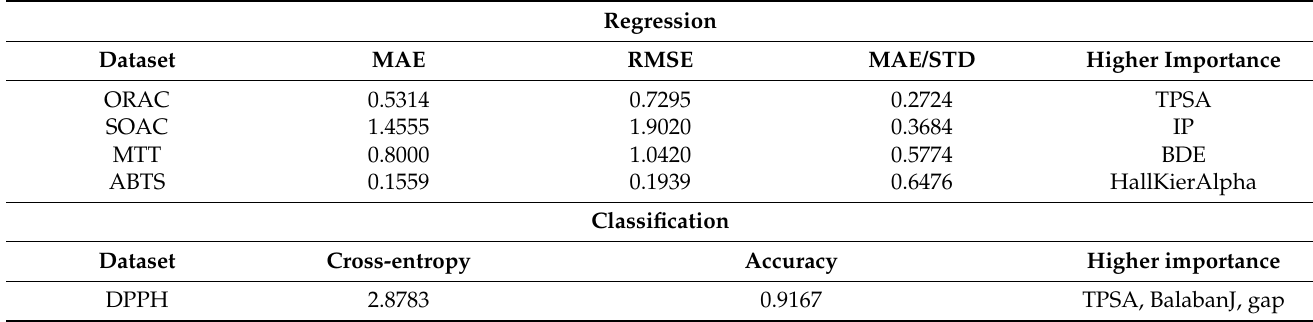
Table 3. Evaluation of the performance of XGBoost models for prediction of test data properties. Lower MAE, RMSE, and cross-entropy are better. Higher accuracy shows a better performance. MAE/STD is the MAE divided by the standard deviation of target values in each dataset. The higher importance column lists features with importance greater than 0.85 after